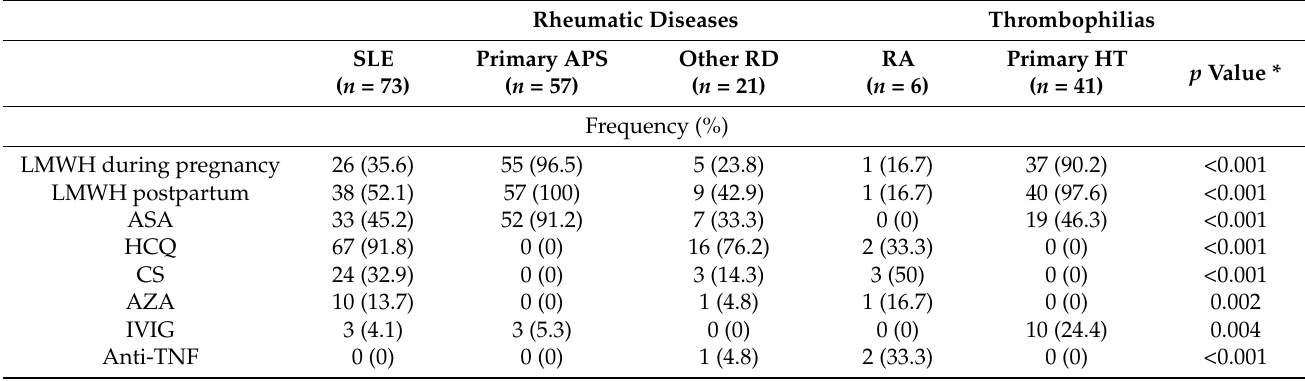
Table 5. Therapies during pregnancy episodes by